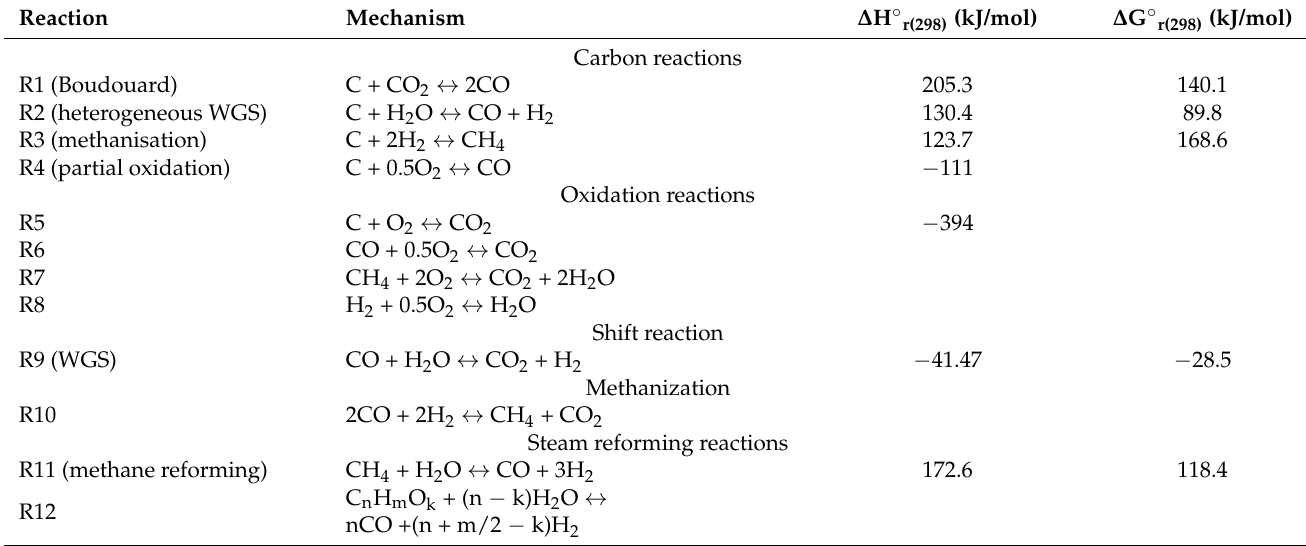
Table 8. Main gasification reactions